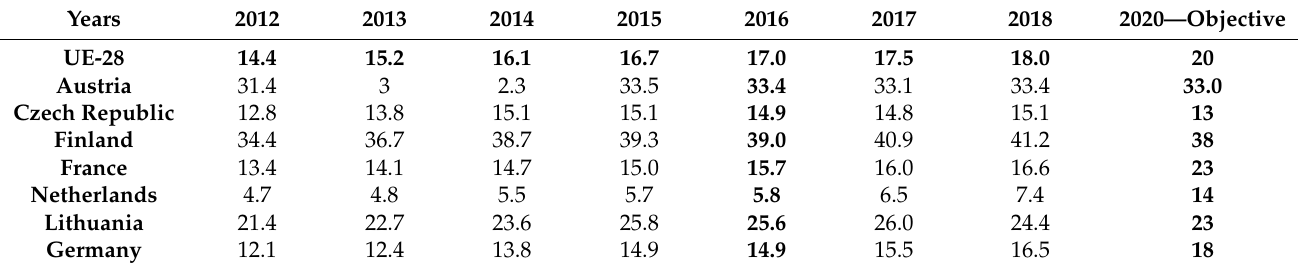
Table 4. Share of energy from renewable sources (in % of the total gross energy